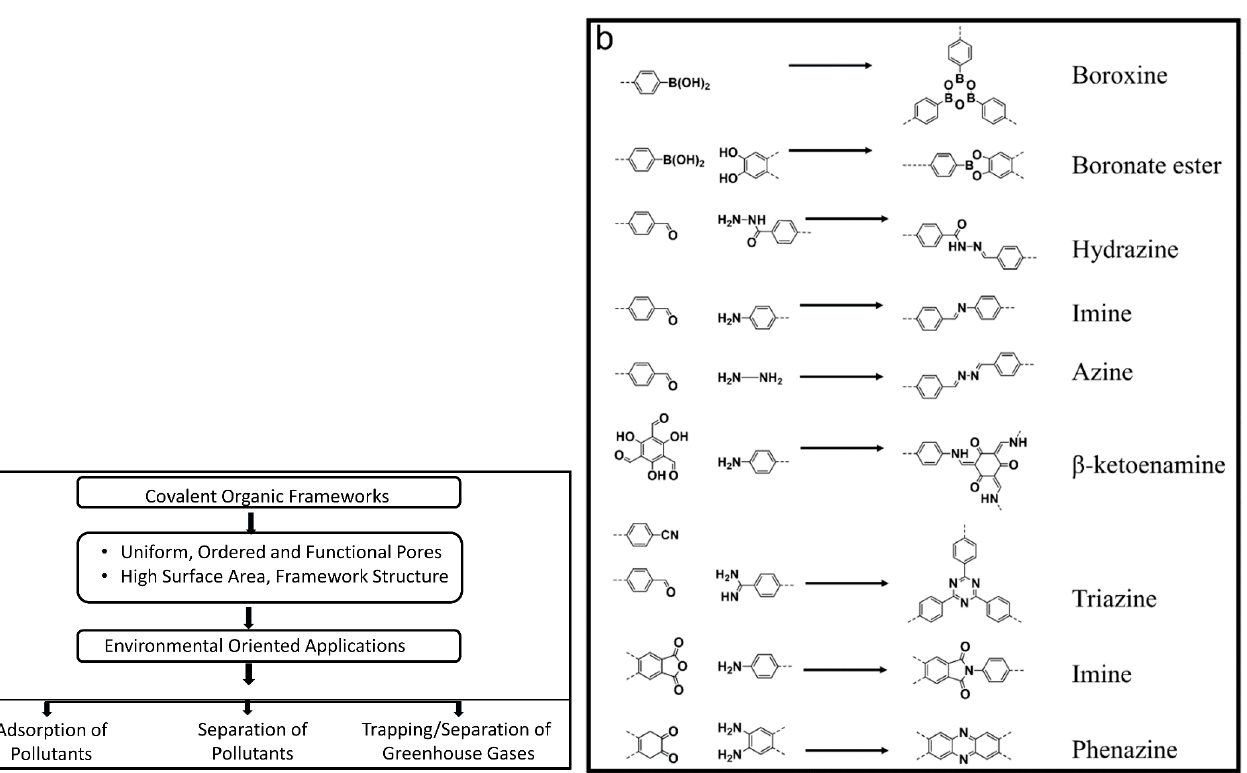
Figure 1. ( a ) Illustration of COFs towards environmental applications and ( b ) important classes of COFs and their pore geometry by binding different linkers.